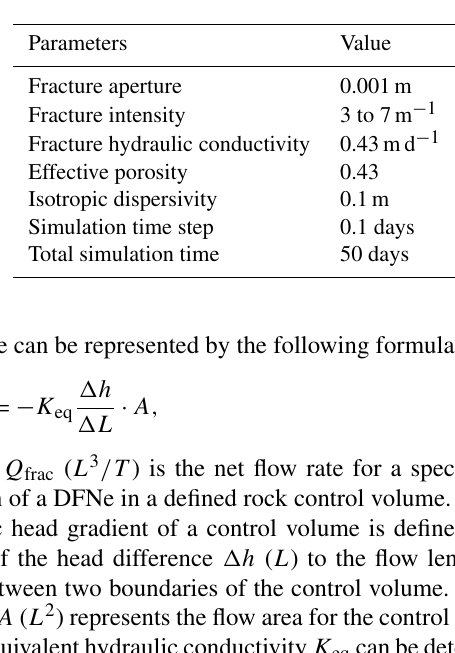
Table 3. Parameters that were used for the transport simulations in the 3-D DFNe realizations.